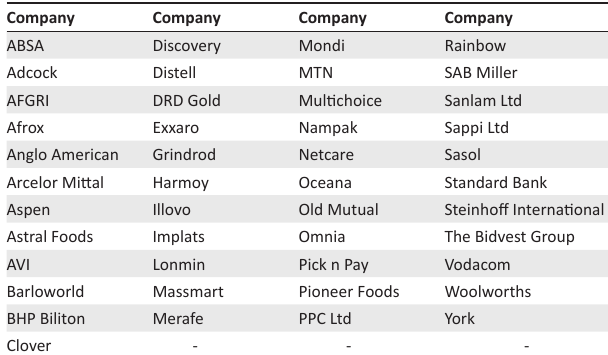
TABLE 3: List of companies that form the sample for the